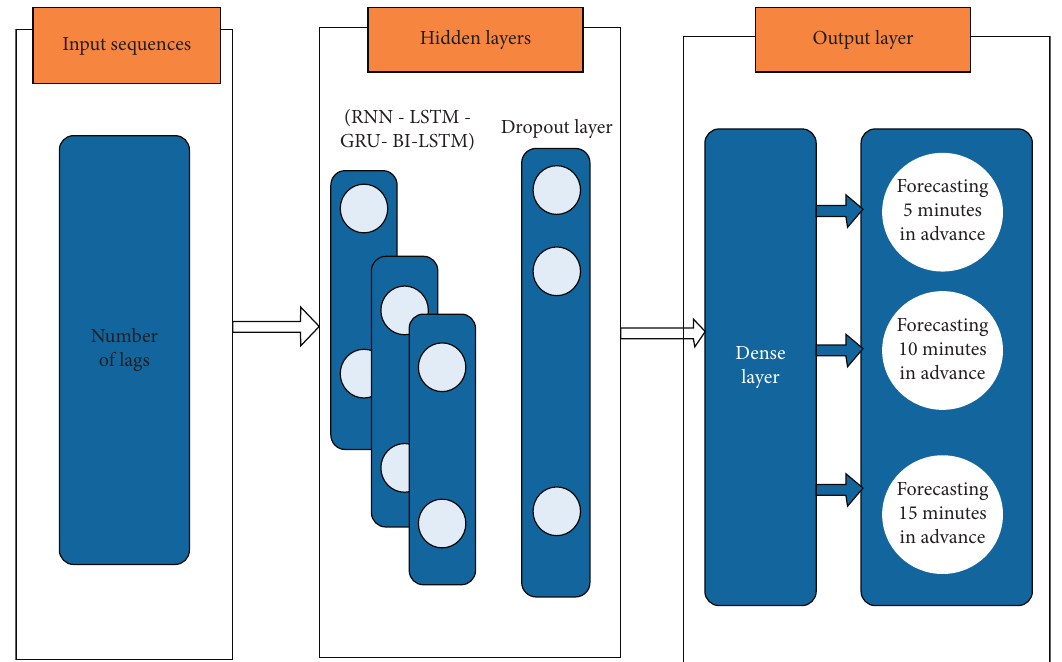
Figure 3: The architecture of neural network for heart rate prediction